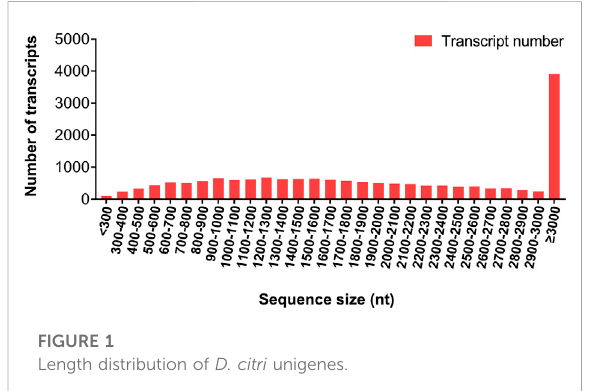
FIGURE 1 Length distribution of D. citri unigenes.